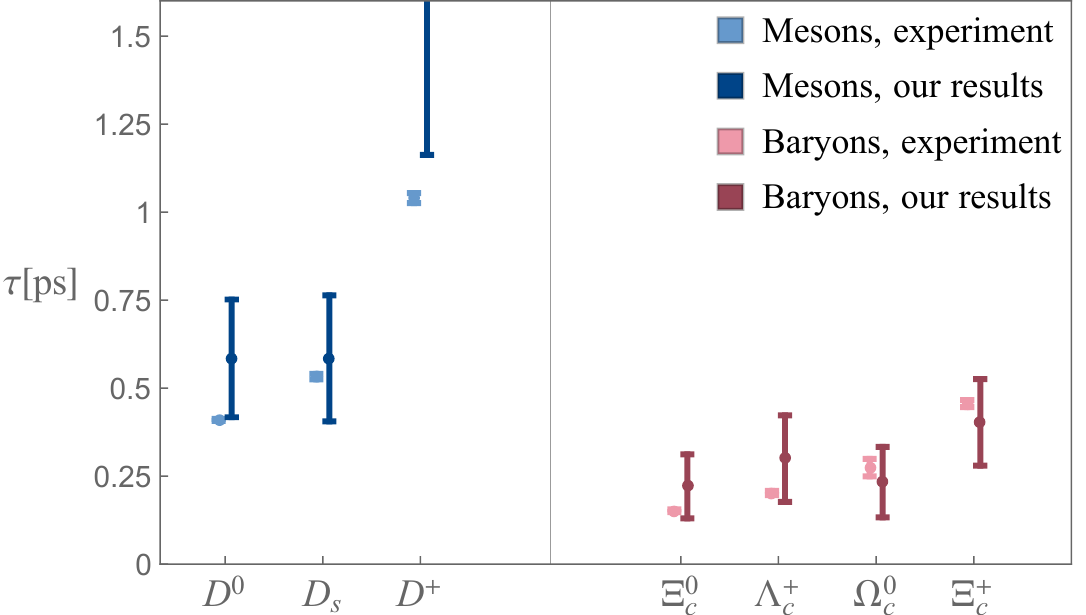
Figure 6. Hierarchy of lifetimes, in ps, of charmed mesons (left, in blue) and singly charmed baryons (right, in red). Experimental values, including the latest LHCb results for Ω 0 are on the left of each pair of values; our predictions, using the kinetic scheme, are on the